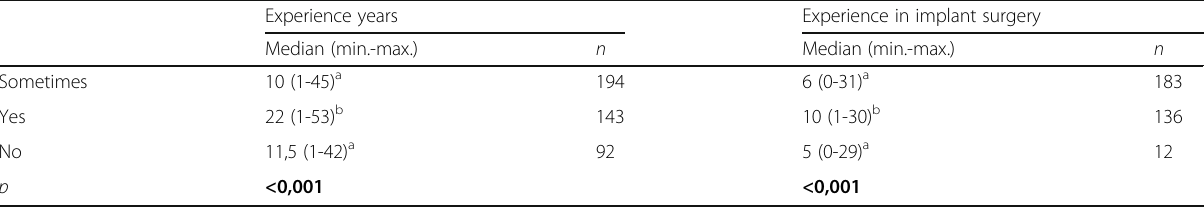
Table 4 The relationship between experience years and preoperative antibiotic prescription habit Experience years Experience in implant surgery Median (min.-max.) n Median